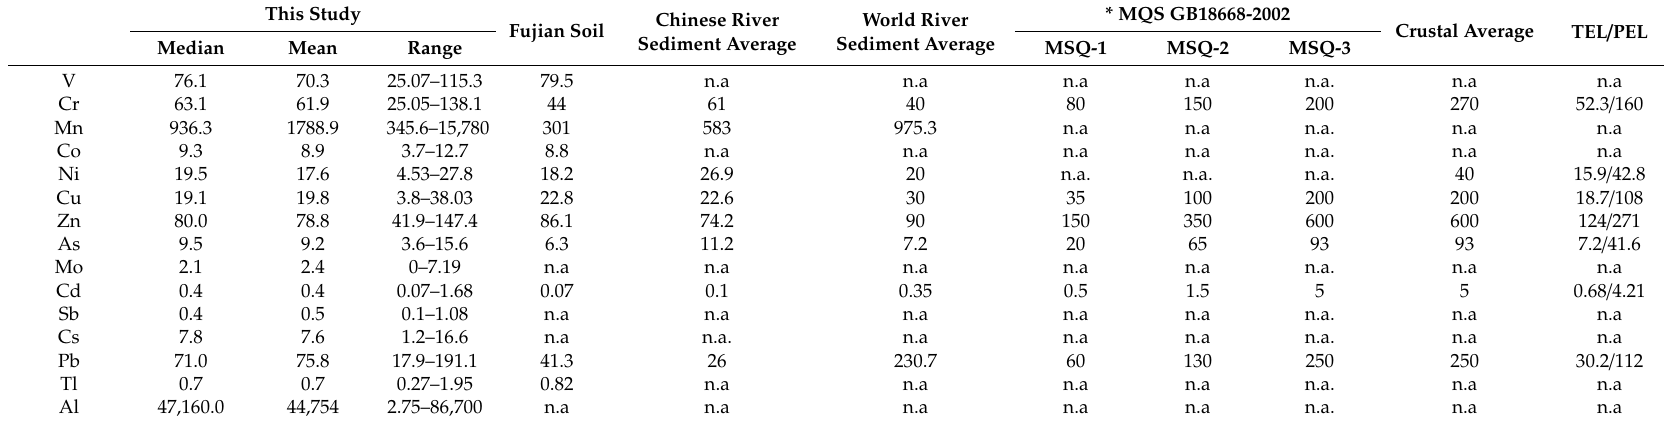
Table 2. Comparison of metal and metalloid elements (MMEs; mg kg − 1 dry weight) in this study (Jiulong River estuary sediments) and other